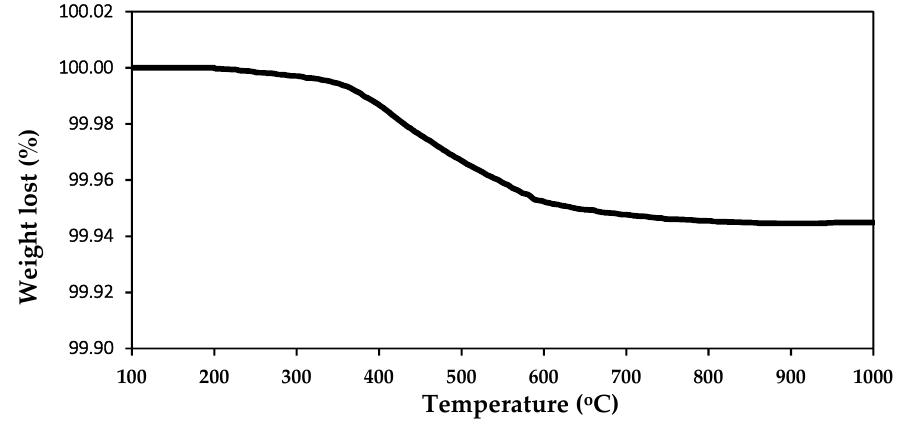
Figure 3. TGA curve of silica powder.